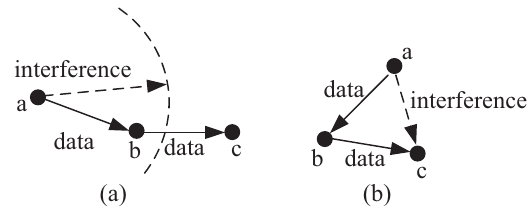
Figure 1. An example of the interference in the FD model. ( a ) node c is not in the interference range of node a ( b ) node c is in the interference range of node a